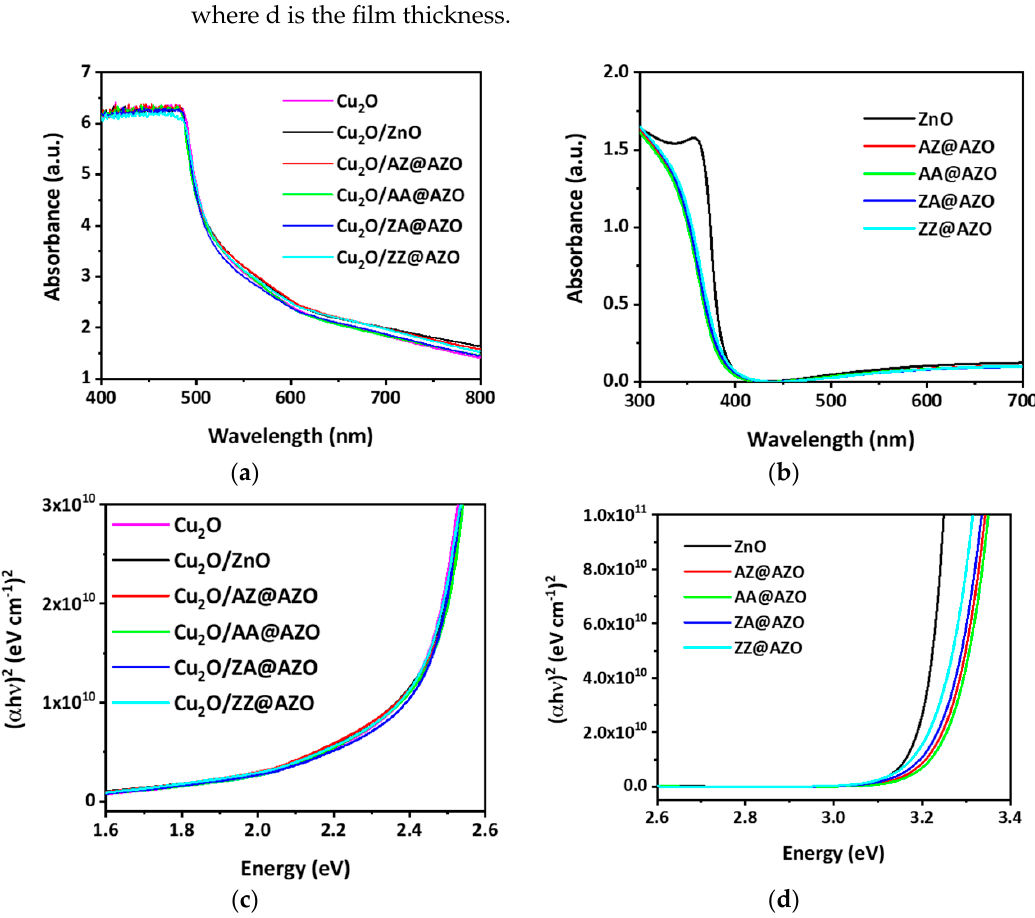
Figure 2. ( a , b ) UV-Vis-NIR absorption spectra, and ( c , d ) Tauc plots of ( a , c ) pristine and overlayered Cu 2 O and ( b , d ) ZnO and AZO overlayers.